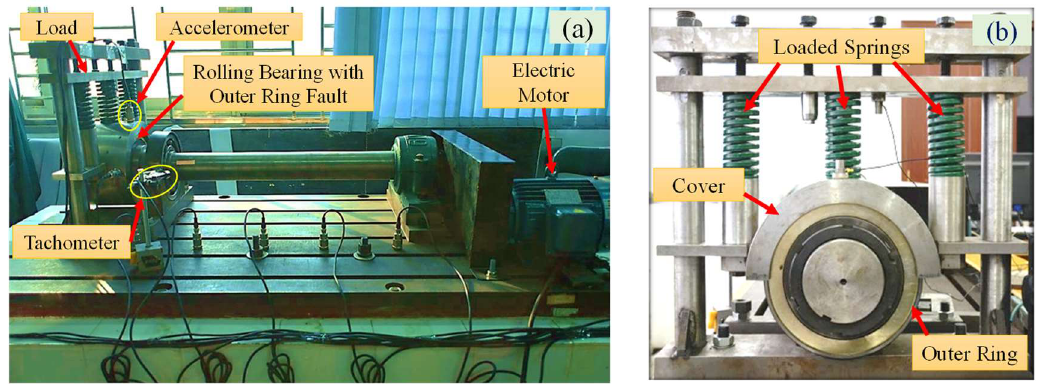
Figure 8. ( a ) The rolling bearing test rig of high-speed train; ( b ) the bearing loading device.